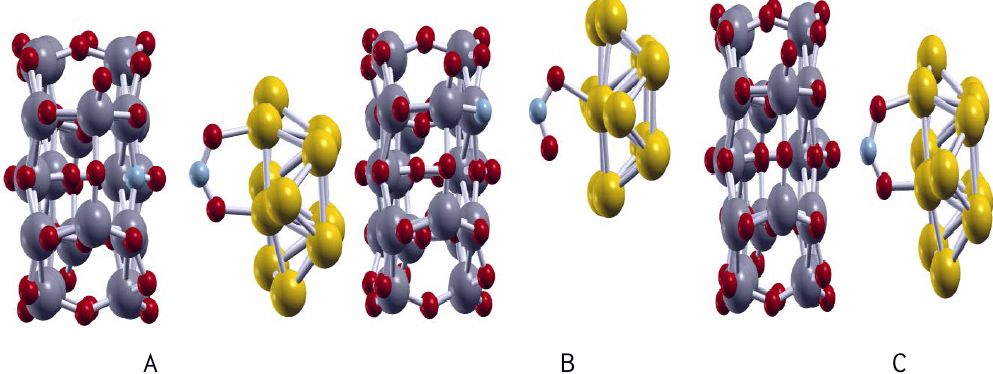
Fig. 6. Top view of the optimized geometry configurations of the interaction of NO 2 molecule with TiO 2 /Gold nanocomposites. The NO 2 molecule is preferentially adsorbed on the Au particle surface.